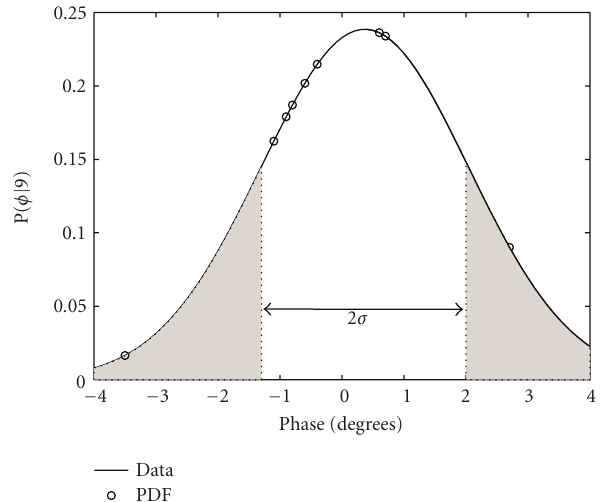
Figure 22: The theoretical prediction of overall array amplitude cal- ibration accuracy based upon the use of the coupler hardware of Section 4.1.